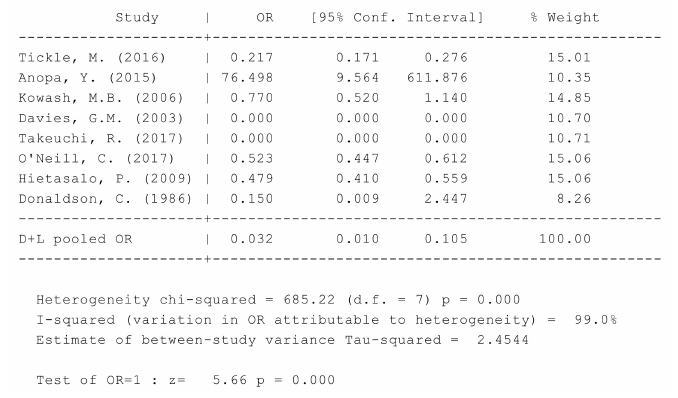
Figure A2. STATA do-file for analysis of Figure 3. “metan DMFTintervention